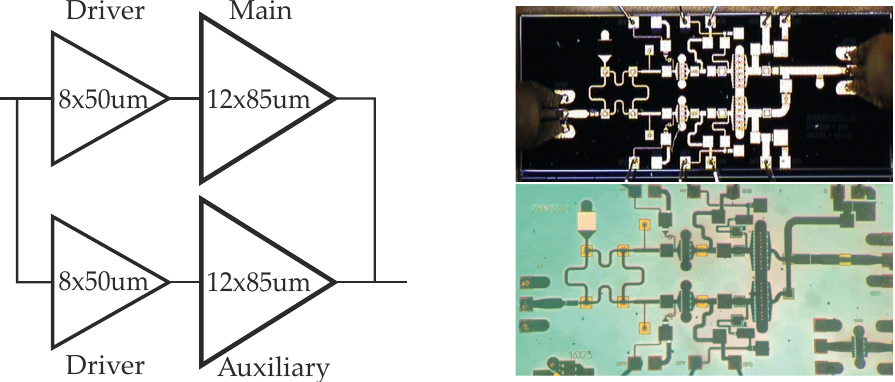
Figure 1. Block diagram ( left ) and chip photographs of the DPAs in [12] ( top ) ©IEEE 2014 and [13] ( bottom ) ©IEEE 2021.